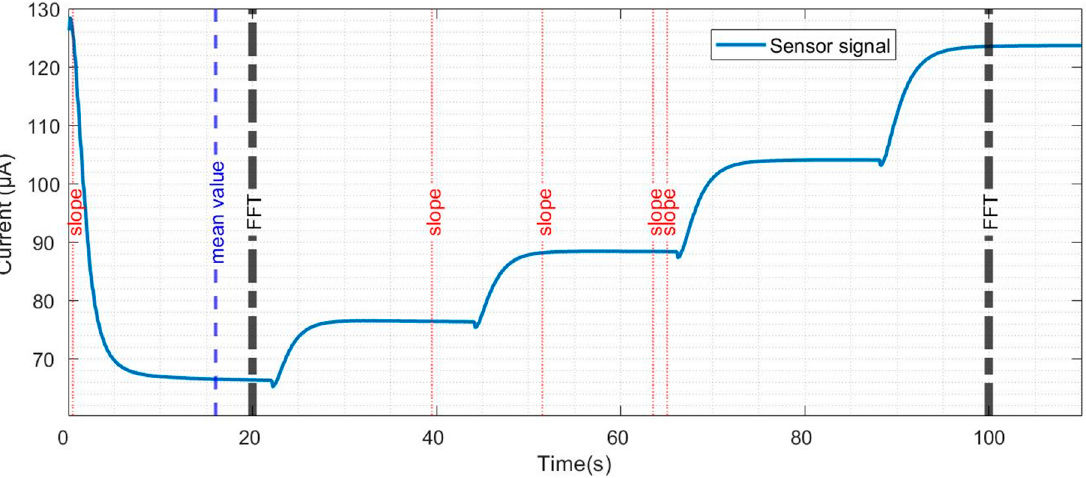
Figure 2. Current evolution of a SiC-based field-effect transistor sensor during a temperature cycle, and the features selected for pattern recognition.